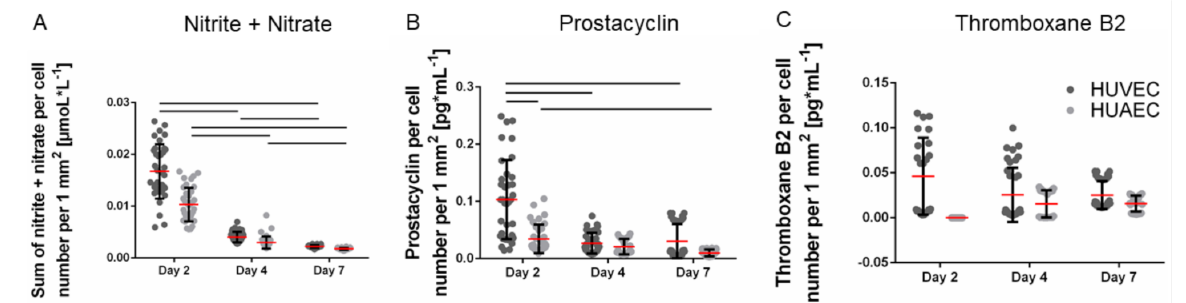
Figure 4. Secretion of vasoactive substances by endothelial cells. Human umbilical cord-derived endothelial cells from veins (HUVEC) or arteries (HUAEC) were seeded at a density of 15,000 cells/well at day 0 and cultivated for 2, 4, and 7 days. The amounts of the sum of nitrite and nitrate ( A ), prostacyclin ( B ), and thromboxane B2 ( C ) were quantified by ELISA and normalized to the number of vital adherent cells per mm 2 . While less nitrite/nitrate and prostacyclin were released over time, the amount of thromboxane B2 remained constant. Straight black lines indicate p ≤